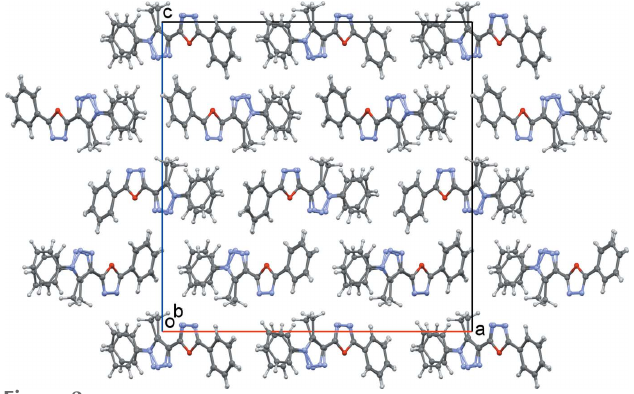
Figure 2 Crystal packing viewed down the b